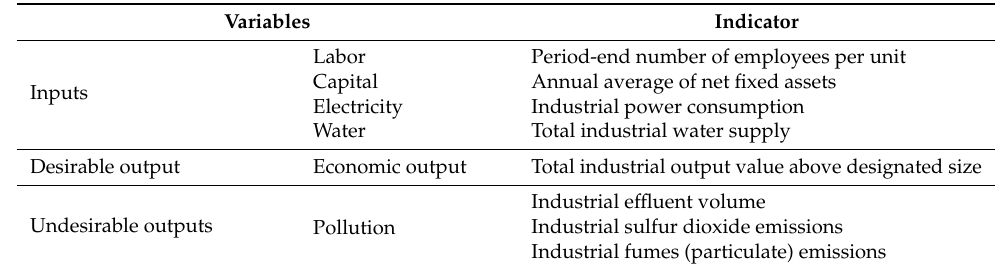
Table 2. Input and